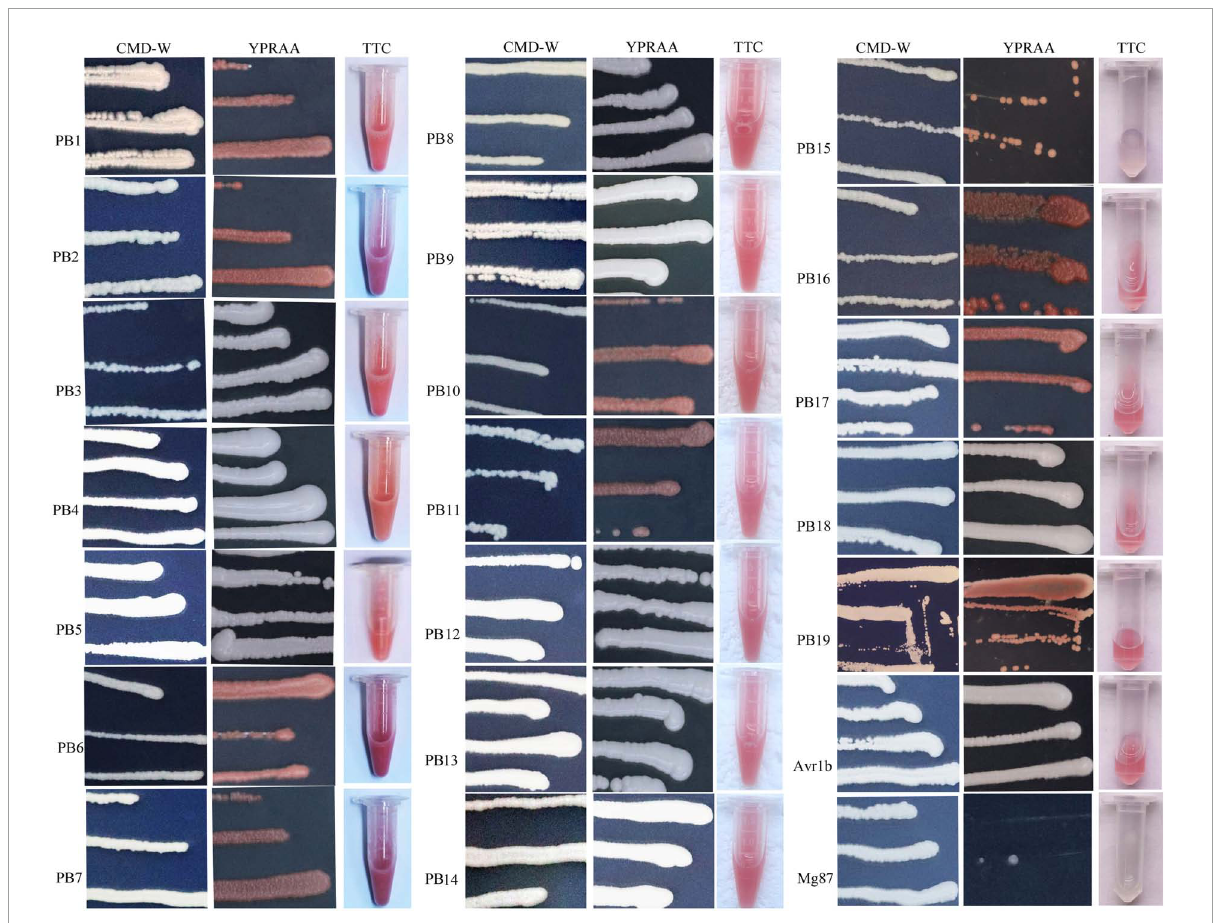
FIGURE7 Functional validation of signal peptides from the putative secretory proteins of P. brassicae . YTK12 transformed with the corresponding pSUC-based construct was grown in CMD-W (proving the ability to produce tryptophan) and YPRAA (proving the ability to export invertase to the media). SPs from Phytophthora sojae Avr1b were used as the positive control, and Magnaporthe oryzae Mg87 served as the negative